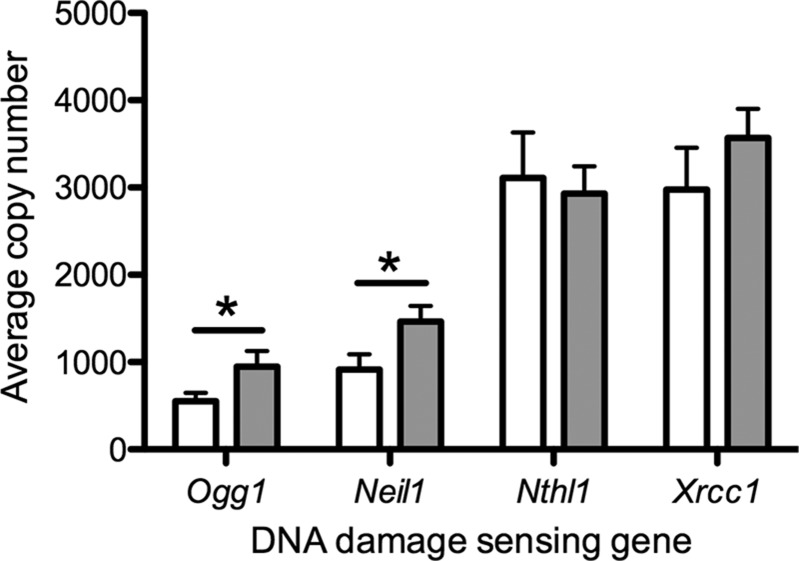
Effect of gestational hypoxia compared to normoxia on DNA damage–sensing gene expression in the ovary of adult female rats. Data shown as means ± sem. Open bars: normoxia (21% oxygen) during gestation; gray bars: hypoxia (13% oxygen) during gestation. *P < 0.05.